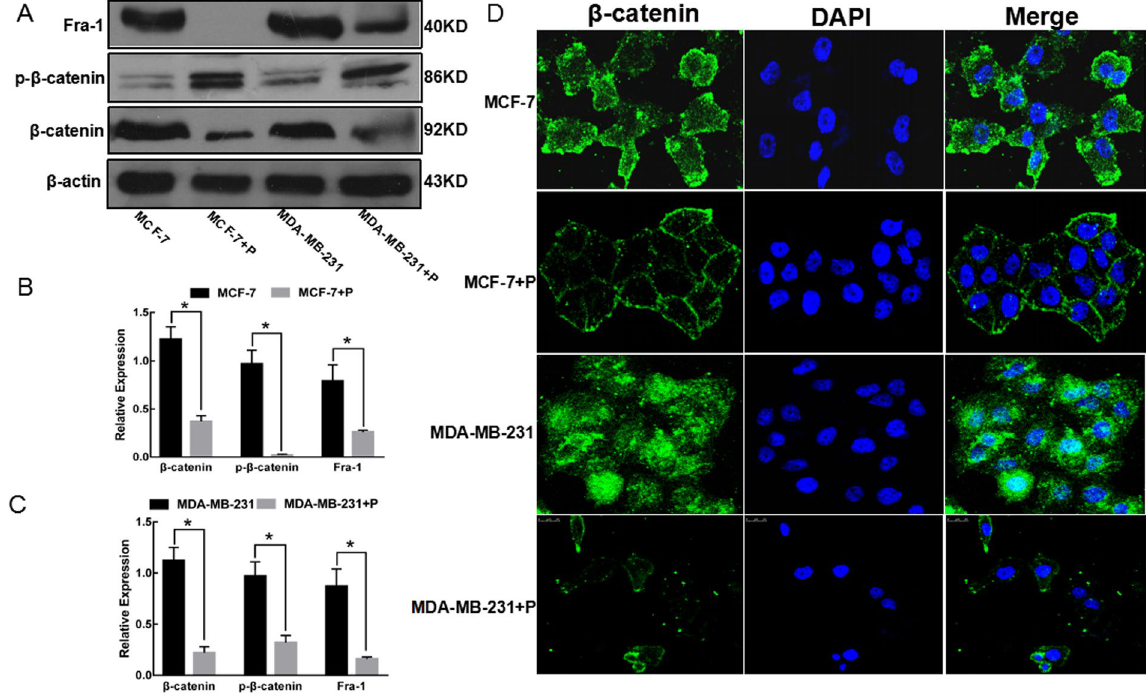
Figure 3. Effects of psoralen on the Wnt/ β -catenin signaling. ( A ) Western blot analysis exhibited the expression of β -catenin and its downstream target gene Fra-1 in MCF-7 and MDA-MB-231 cells treated with psoralen for 72 h. ( B , C ) Bar graphs represent the mean normalized densitometry values of β -catenin and Fra-1 in MCF-7 and MDA-MB-231 cells, * p < 0.05 compared with the control group. Data are means ± SD of three independent experiments. ( D ) The distributions of β -catenin in the cytoplasm and nucleus were detected by immunofluorescence. The results showed strong cytoplasmic and nuclear localization of β -catenin in MCF-7 cells and MDA-MB-231 cells as well as typical membranous β -catenin expression in the cell-cell contacts after psoralen